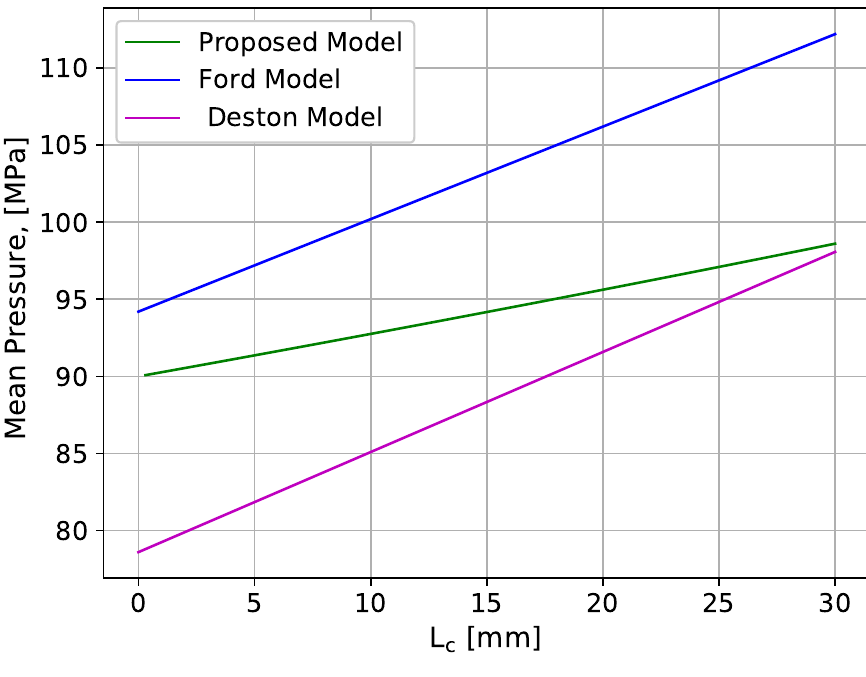
Figure 12. Mean pressure versus contact length